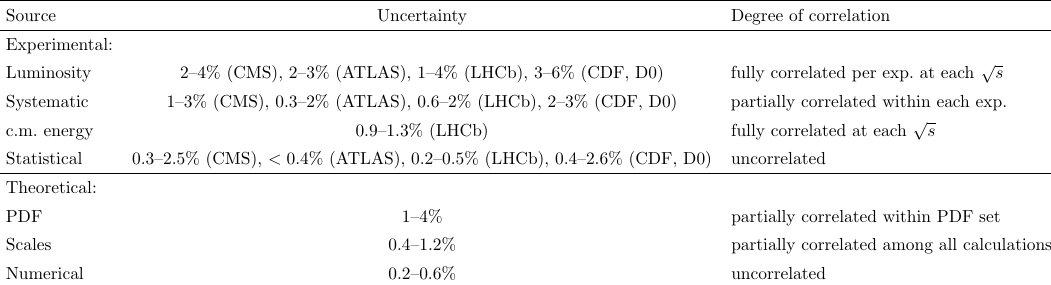
Table 4 . Typical ATLAS, CMS, LHCb and Tevatron experimental and theoretical uncertainties in the W (cid:6) and Z boson production cross sections, and their degree of correlation (described in more detail in section